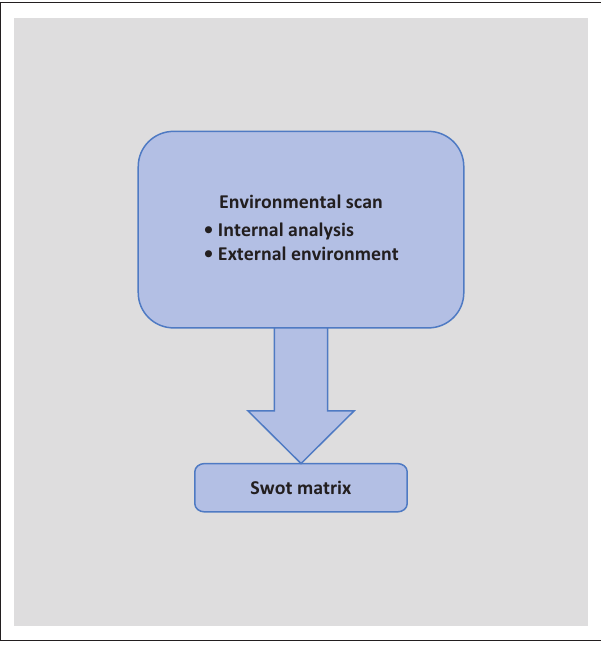
FIGURE 1: Linkage between environmental analysis and Strengths, Weaknesses, Opportunities and Threats